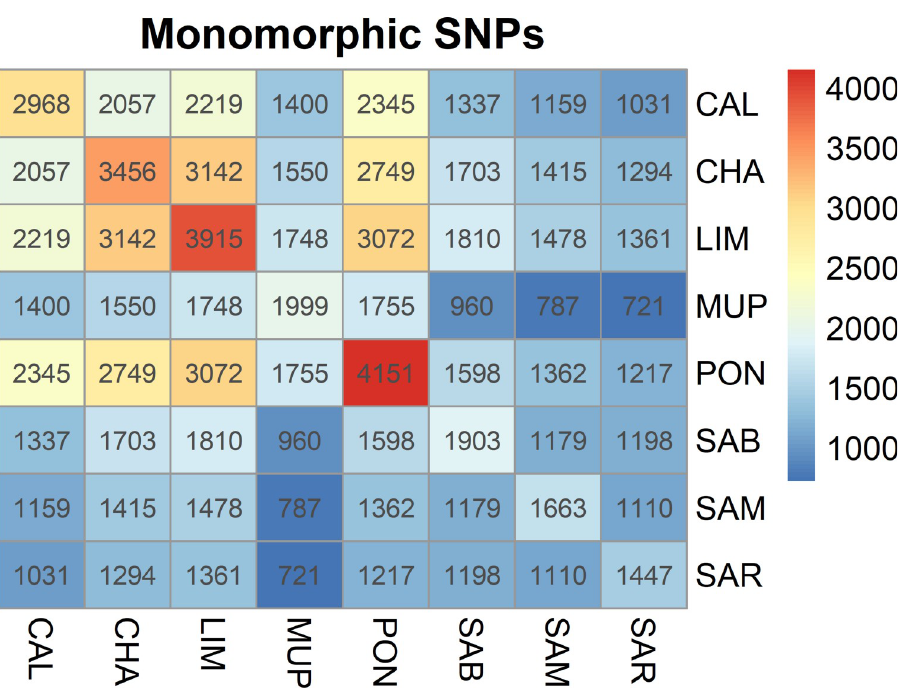
Fig 1. Heatmap of monomorphic SNPs pairs comparison among breeds; CAL = Calvana; CHA = Charolais; LIM = Limousine; MUP = Mucca Pisana; PON = Pontremolese; SAB = Sardo Bruna; SAM = Sardo Modicana; SAR =